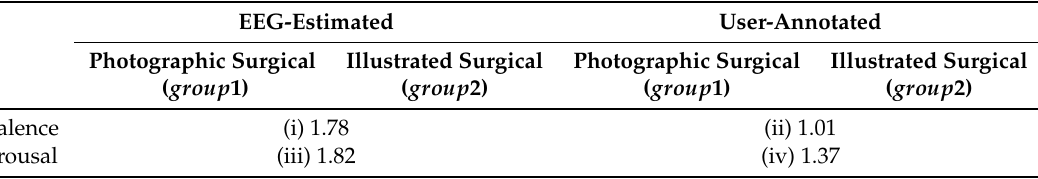
Table 5. Cohen’s d values to measure the difference in emotional reaction between photographic and illustrated surgical images.